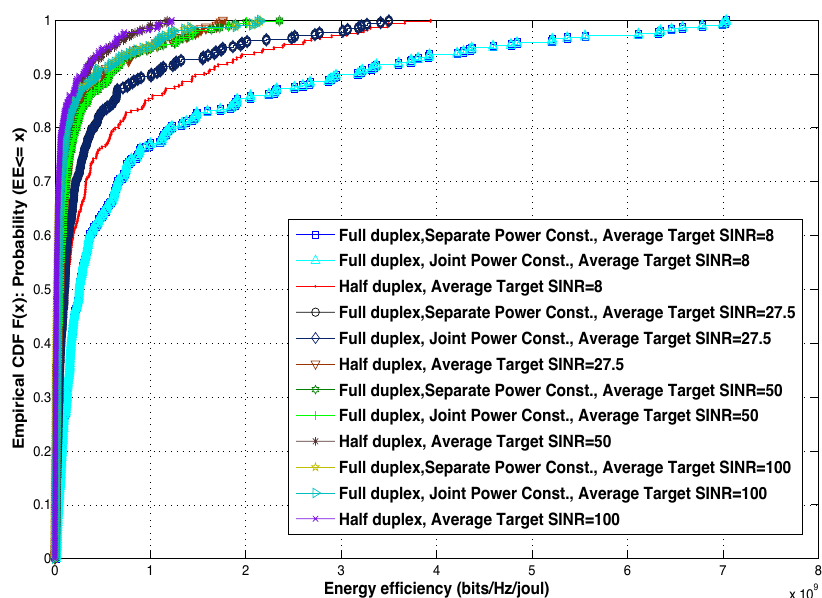
Figure 3. The CDF of the average energy efficiency (EE) of a 12-cell network using different transmission schemes under different average target SINR.